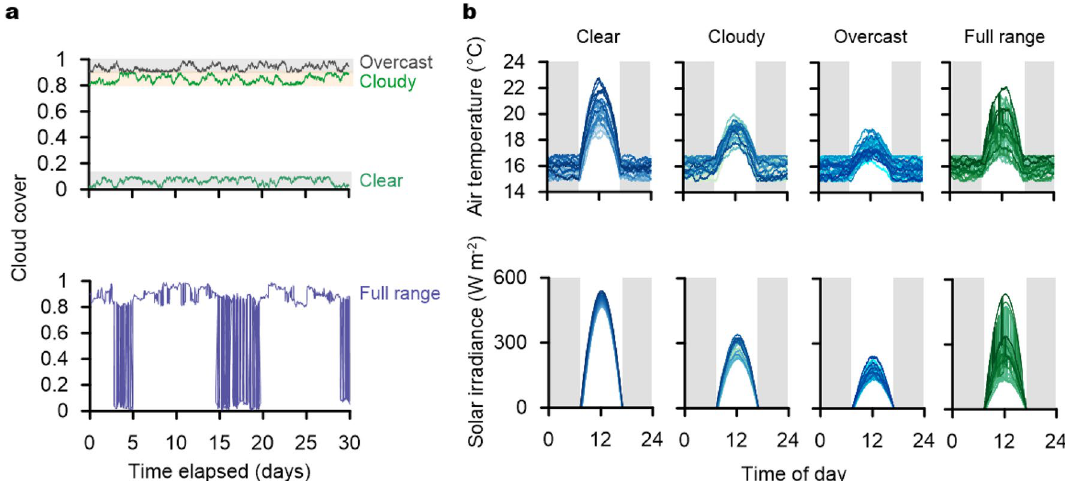
Figure 2. Climatic regimes for the coupled simulation analysis ( a ) representation of the random walk progress for four cloud cover classes and ( b ) superposition of generated curves for the solar irradiance and the air temperature patterns accounting for respective cloud cover classes during all simulation